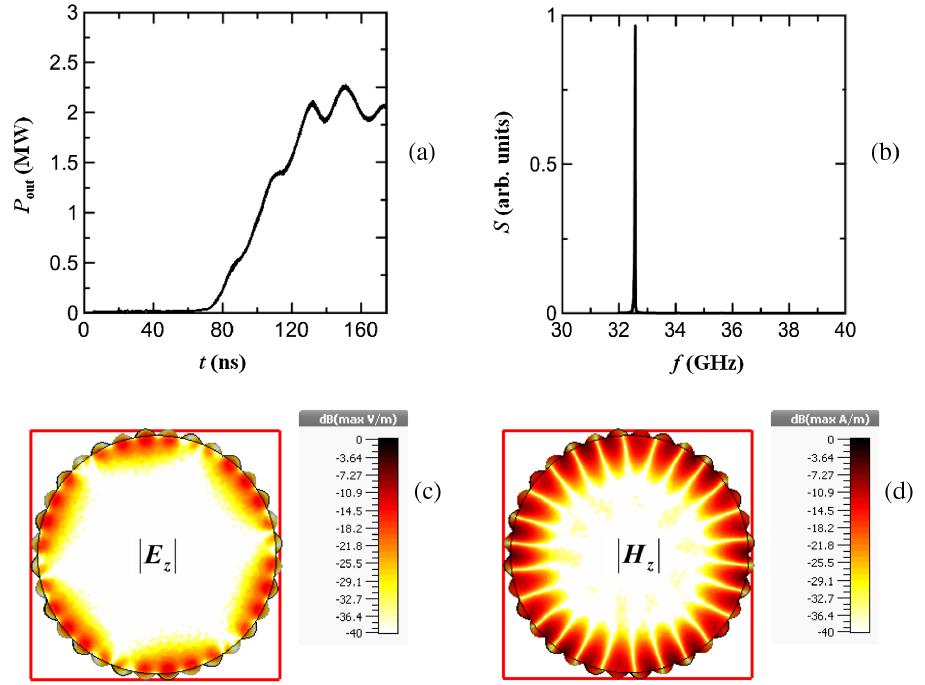
FIG. 8. Results of 3D CST PIC simulations for parameters corresponding to the experimental conditions at the SATURN accelerator: (a) Temporal dependence of the output power P , (b) rf spectrum S at the final stage of the evolution and spatial structure of the field out components, (c) E and (d) H at the central cross z z